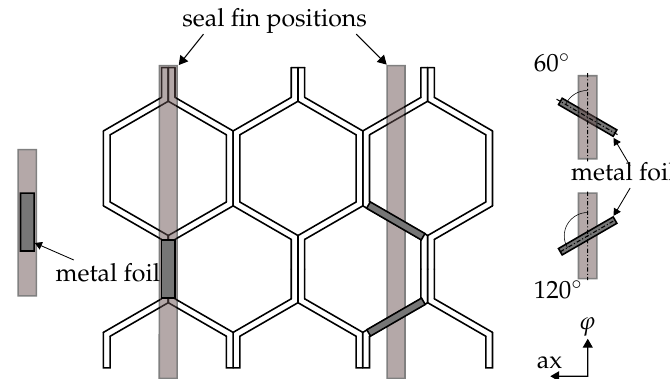
Figure 1. Schematic drawing of a honeycomb liner and extreme positions of a labyrinth seal fin, modified according to [18].